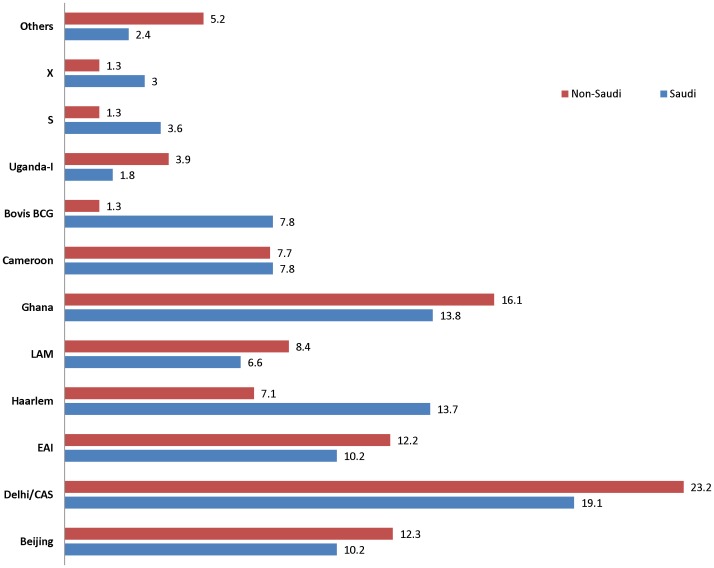
Distributions of M. tuberculosis complex strain lineages among Saudi and non-Saudi cases.Lineages identified as described in text were segregated as per “Saudi” and “Non-Saudi” nationalities. Bar diagrams show the proportion (in percentage) of each lineage in each of these two groups. The lineages TUR, NEW-I and URAL were clubbed under the label “Others” as the corresponding isolates are very few in number.